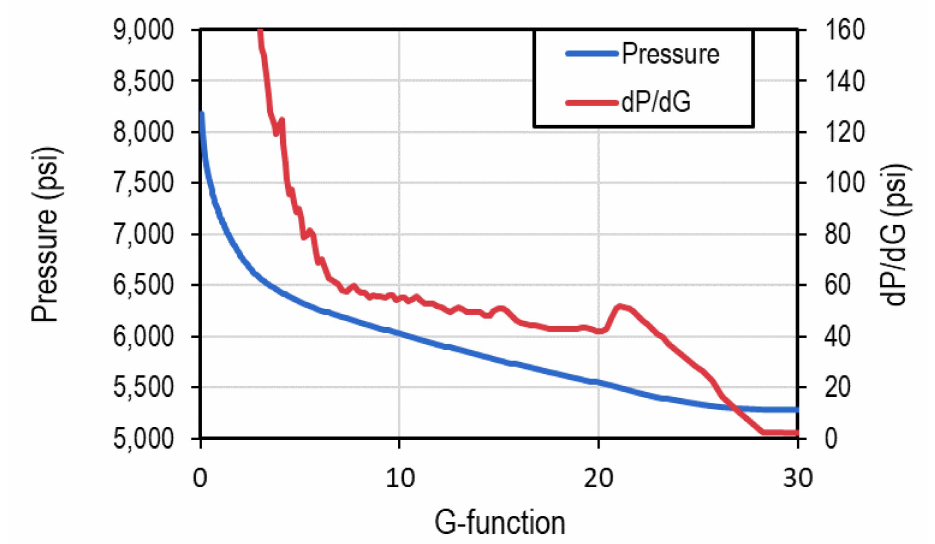
Figure 11. DFIT analysis using the compliance method for Well #1 (Woodford